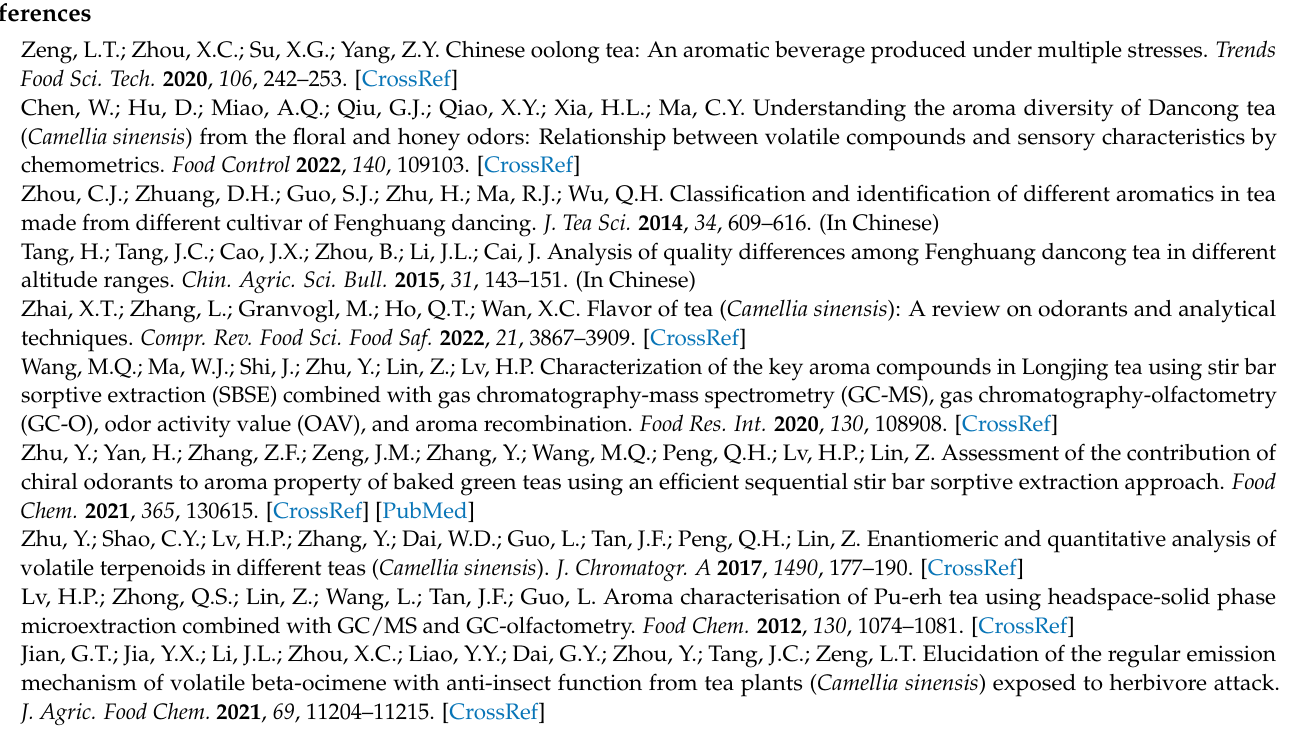
Figure S2: Expression level of CsLISs in fresh leaves and wounded leaves of Lingtou Dancong grown at different altitudes; Table S1: Threshold information; Table S2: The primers used for quantitative real time PCR (qRT-PCR) in the study; Table S3: Detailed information of Lingtou Dancong tea product at high altitude; Table S4: Detailed information of Lingtou Dancong tea product at medium altitude; Table S5: Detailed information of Lingtou Dancong tea product at low